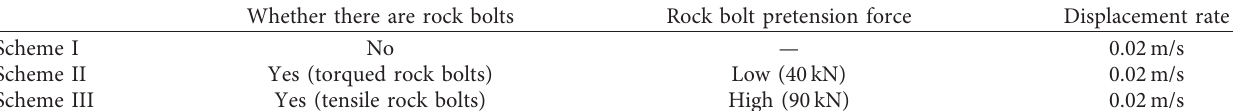
Table 5: Numerical simulation scheme.